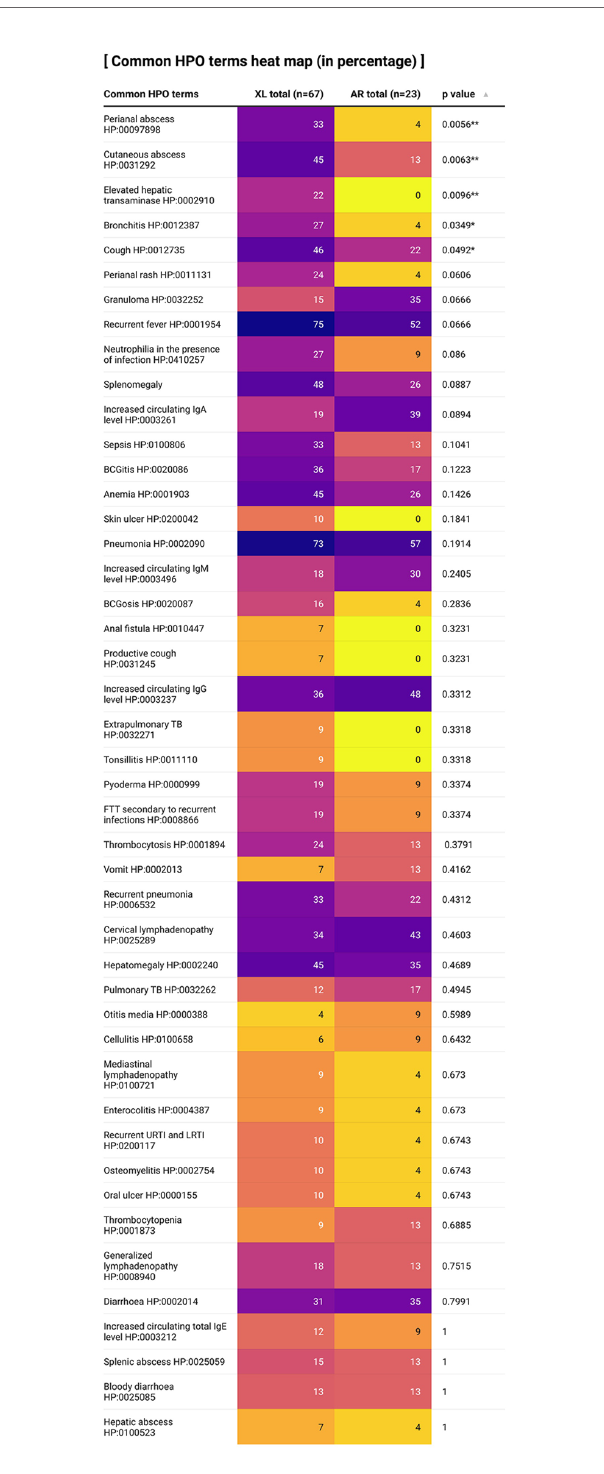
FIGURE 5 | A heat map describing percentages of CGD patients in our case series where their clinical records displayed certain phenotypic abnormalities. Fisher ’ s exact test is used for statistical analysis (Only more than 5% of patients describing certain HPO term is recorded). HPO, Human Phenotype Ontology. Note: ** p < 0.01; * p < 0.05. This graph is created by using the app